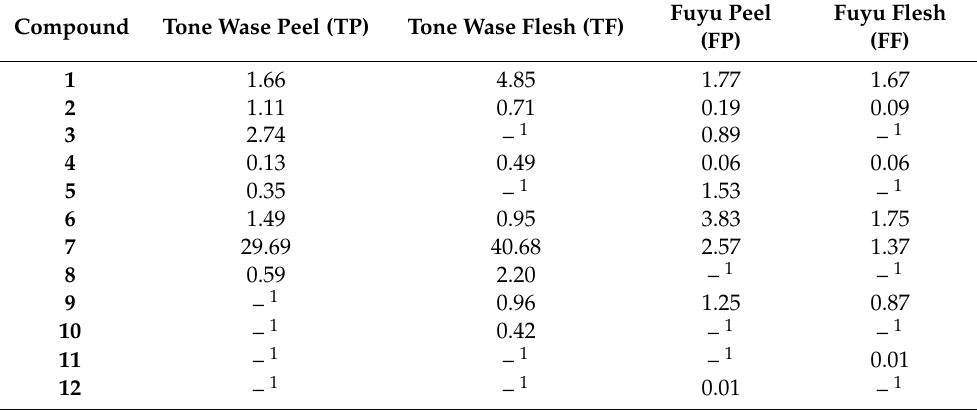
Table 2. Distribution and yields of isolated compounds (crude extracts).